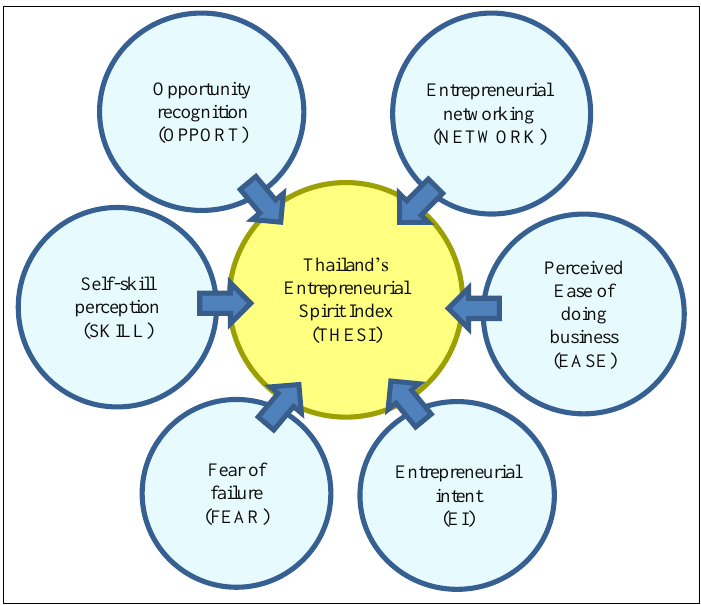
Figure 1. Conceptual Framework of Thailand’s Entrepreneurial Spirit Index